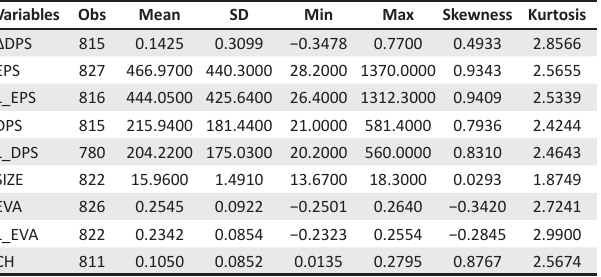
TABLE 3: Descriptive analysis for all variables of Panel 2–Value companies.